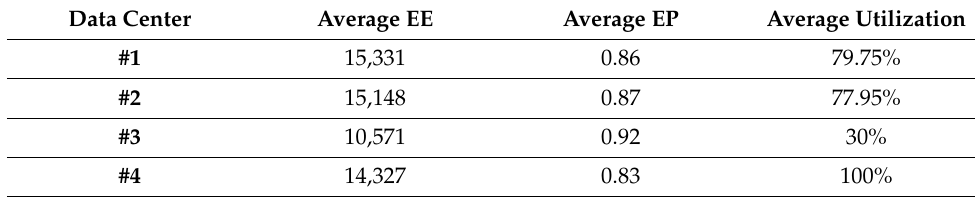
Table 3. The average EE and EP of the four data centers with a power limit of 1000 KW.